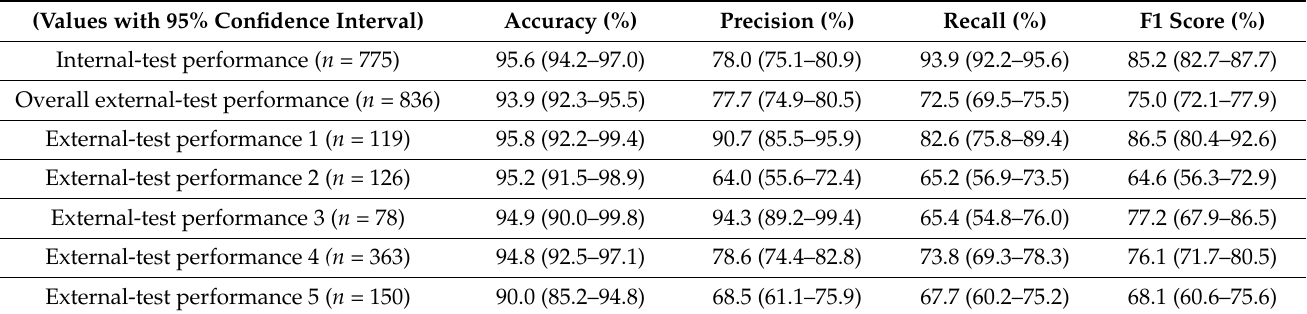
Table 3. Summary of the internal- and external-test performance metrics for the established deep- learning model.